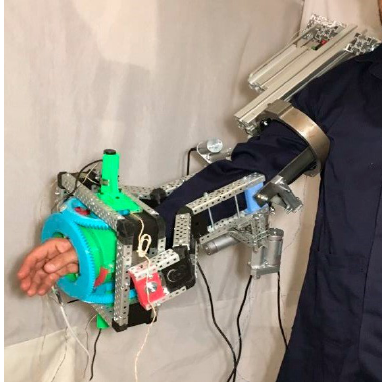
Figure 7. The experimental physical model of ERMIS.